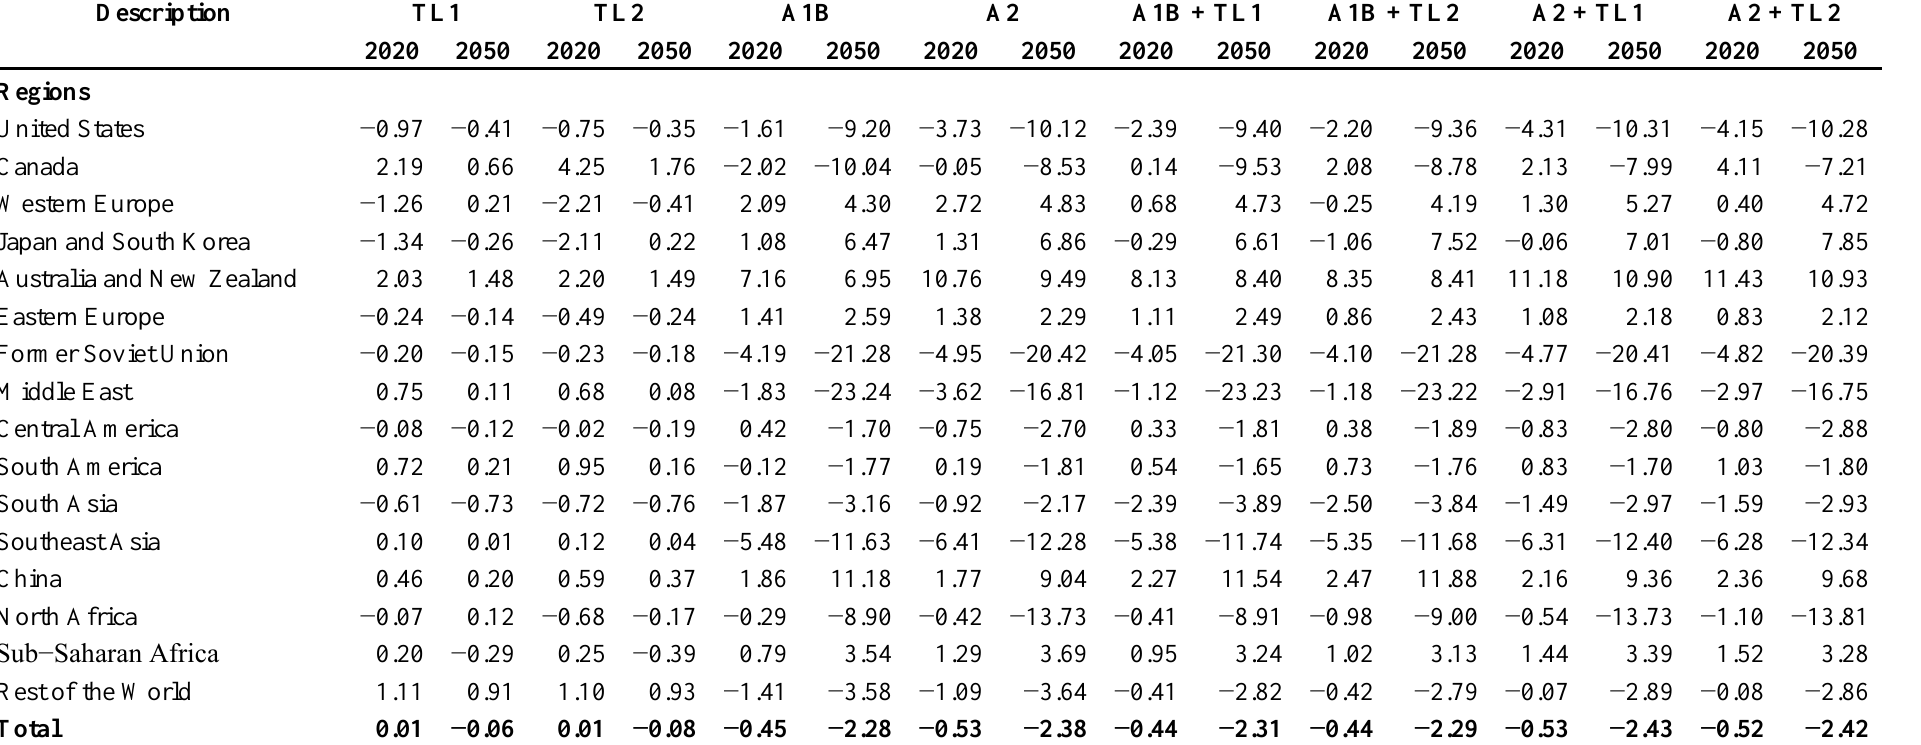
Table B3. Change in agricultural production in 2020 and 2050 (in %) relative to